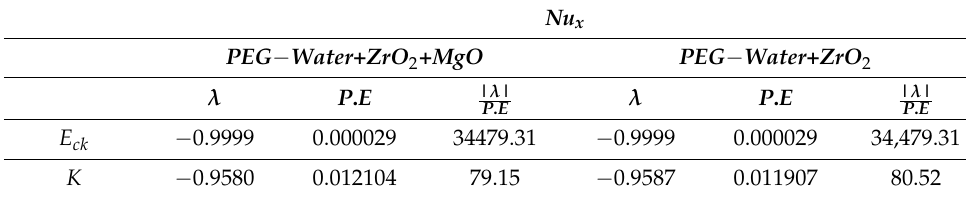
Table 4. Some factors’ link with heat transfer rate.